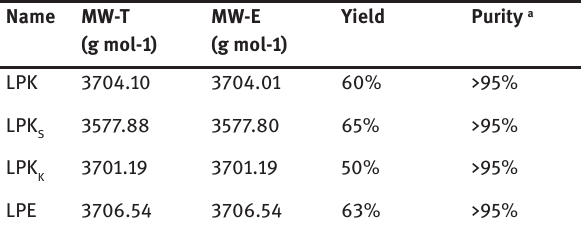
Table 6: Lipopeptides used in this